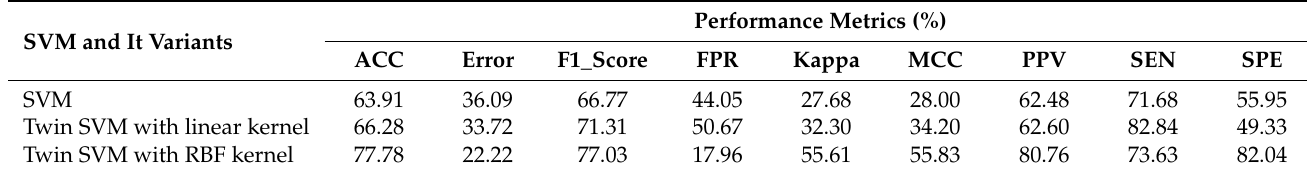
Figure 4. Confusion matrices of ( a ) XGB, ( b ) RF, ( c ) SVM, ( d ) Twin-SVM with linear kernel, and ( e ) Twin-SVM with RBF kernel for evaluating their class-wise performance. Table 4. Comparative performance of SVM and its two